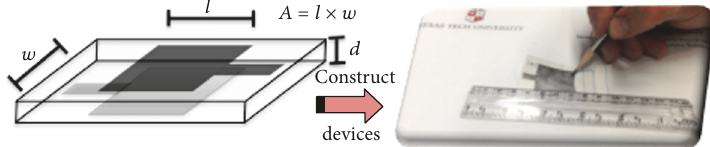
Figure 1: Rendering of pencil-on-paper capacitor. Graphite traces on opposing sides of paper serve as conductive plates and the paper is the capacitors dielectric.